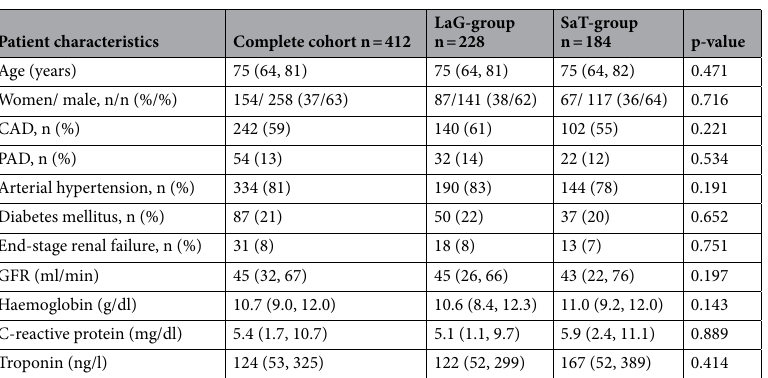
Table 1. Baseline characteristics of the study population. Categorical variables are reported as absolute values and percentages, whereas continuous data are expressed as median with interquartile range. IHCA In-hospital cardiac arrest, LaG Load-and-Go, SaT Stay-and-Treat, CAD coronary artery disease, PAD peripheral arterial disease, GFR glomerular fraction